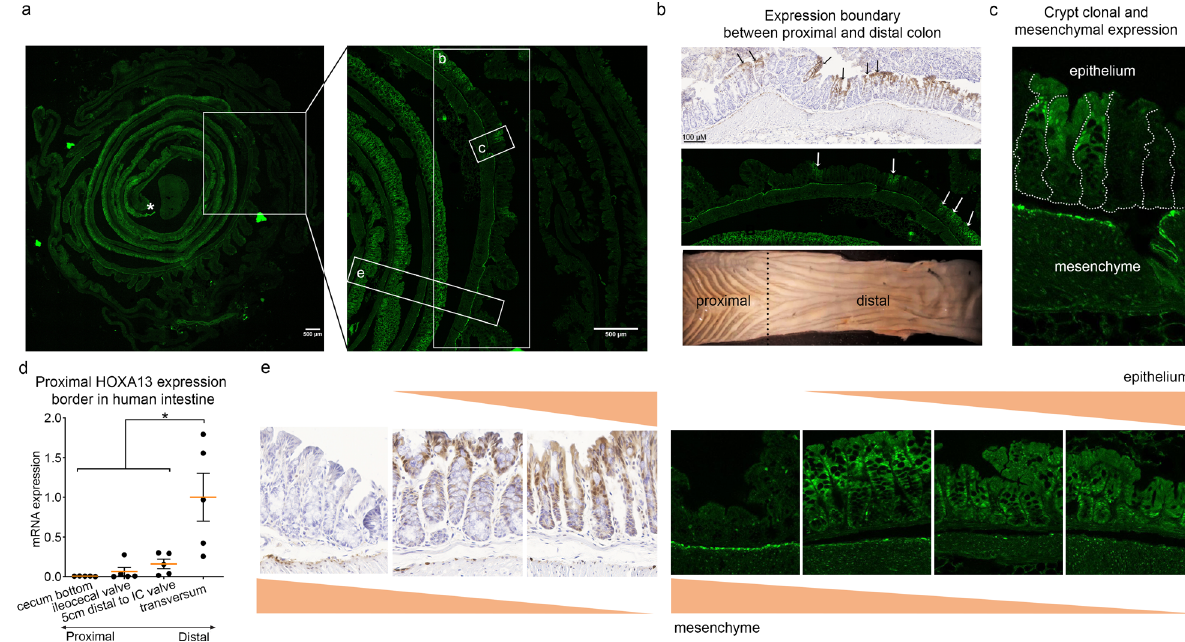
Fig. 2 Murine and human HOXA13 expression is subject to strict spatial control in the colon. a A representative example from 3 mice of a “ Swiss roll ” con fi guration of the large intestine of the Hoxa13-GFP heterozygous mouse model. An asterisk indicates the most distal portion of the epithelium. Magni fi cation of the insets are shown in panels b , c and e . b The proximal border of physiological Hoxa13 expression in the adult mouse is patchy and located between the proximal and distal colon, indicated by a black dashed line in the bottom panel (macroscopic image of an opened mouse colon). Representative images of anti-GFP IHC and confocal microscopy are shown. Arrows indicate crypts that are positive for Hoxa13 among Hoxa13-negative crypts. c The Hoxa13 expression is crypt clonal. This is observed for n = 1. d In adult humans the cecum bottom is negative for HOXA13 while positivity increases distally ( n = 5 independent sampes). Mean ± SEM, * p < 0.05, repeated measures ANOVA with Holm- Š ídák ’ s multiple comparisons test, p = 0.001. HOXA13 mRNA levels were normalized to levels in the transverse colon. e Hoxa13 expression is tightly regulated along the baso-luminal axis. Distally, Hoxa13 is expressed along the entire baso-luminal axis of the colonic crypts, proximally only expression at the luminal side is seen. In addition, a mesenchymal expression is observed in the cells just beneath the epithelium, predominantly in the proximal colon. Anti-GFP IHC and confocal images are